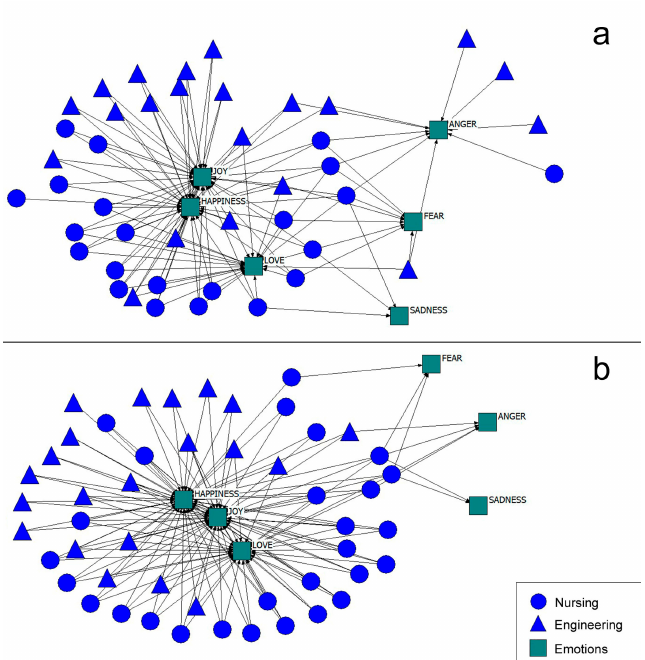
Figure 4. Post-intervention emotion network that are present ( a ) and that shoul be present ( b